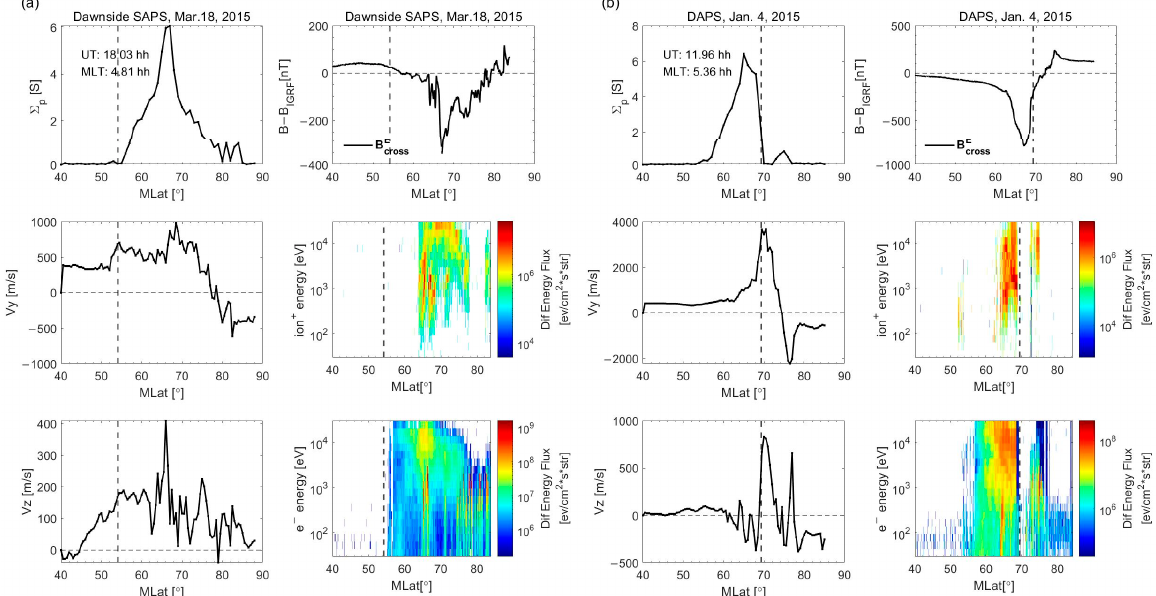
Figure 1. Example latitudinal profiles obtained from DMSP F16. The cross-track plasma velocity (Vy), conductivity ( Σ P ) and vertical velocity (Vz) are shown in the left column of each panel. The right column shows the magnetic field after subtracting IGRF, which is in the horizontal plane and perpendicular to the spacecraft track direction (positive eastward), and differential energy flux of precipitating ions and electrons. The enhanced eastward (positive) plasma drift between 52 ◦ and 56 ◦ is the SAPS ( a ) and that between 67 ◦ and 72 ◦ is the DAPS ( b ), both in the dawn sector. The peak velocity is indicated by the vertical dashed line. The SAPS example occurred on 18 March 2015, and the DAPS case occurred on 4 January 2015. The UTs and MLTs of the peak SAPS and DAPS velocities are also given.